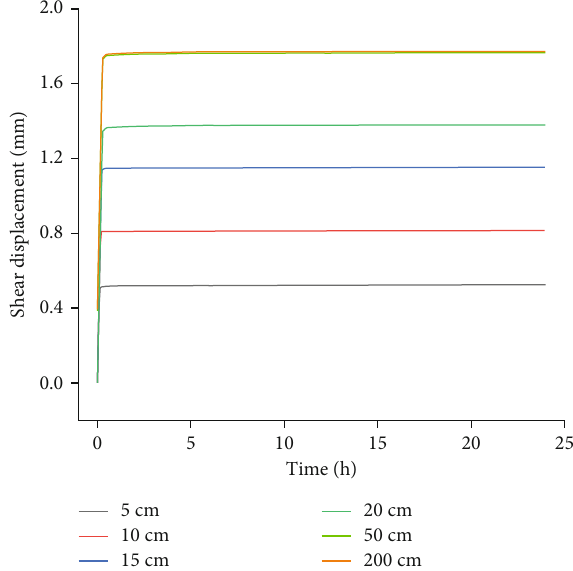
Figure 3: Shear displacement-time curves of models with di ff erent